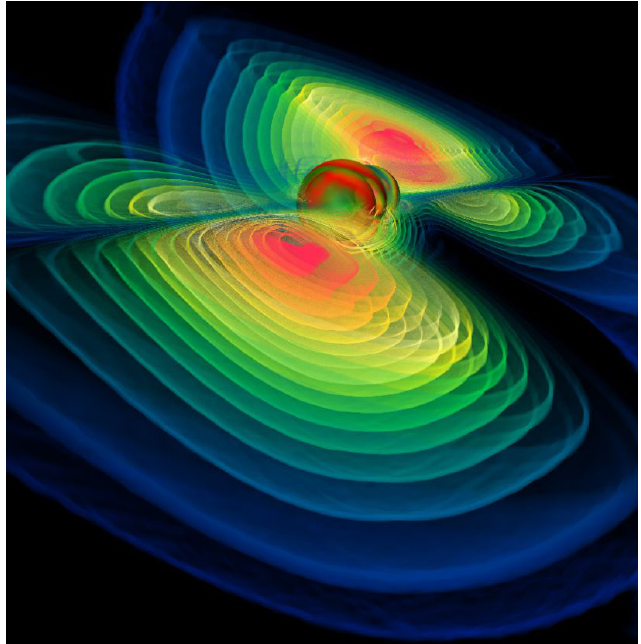
Figure 6. A numerical simulation showing the gravitational radiation emitted by the violent merger of two black holes. Figure taken from Reference [138] with kind permission from B. Brügmann; Credits: Visualisation by Werner Benger, Albert Einstein Institute, Max Planck Institute of Gravitational Physics, Potsdam,